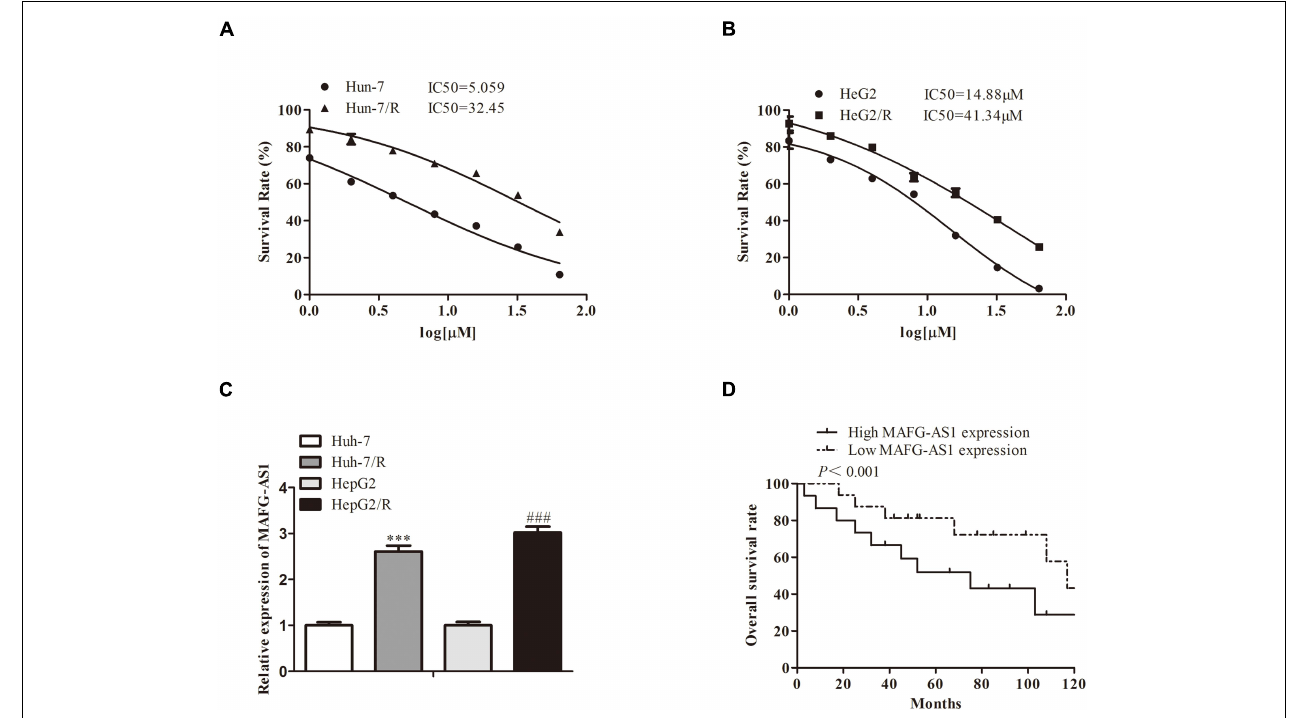
FIGURE 1 | A high expression of MAFG-AS1 is found in drug-resistant cells of liver cancer. (A,B) The half-maximal inhibitory concentration (IC50) values of two liver cancer cell lines. (C) RT-PCR showed that MAFG-AS1 was upregulated in drug-resistant HCC cell lines (Huh7/R, HepG2/R) compared with parental cell lines. (D) The line chart showed the overall survival rate of HCC cell lines with different MAFG-AS1 expression levels.